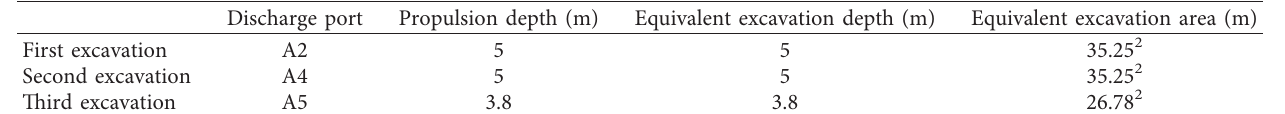
Table 3: Excavation sequence.